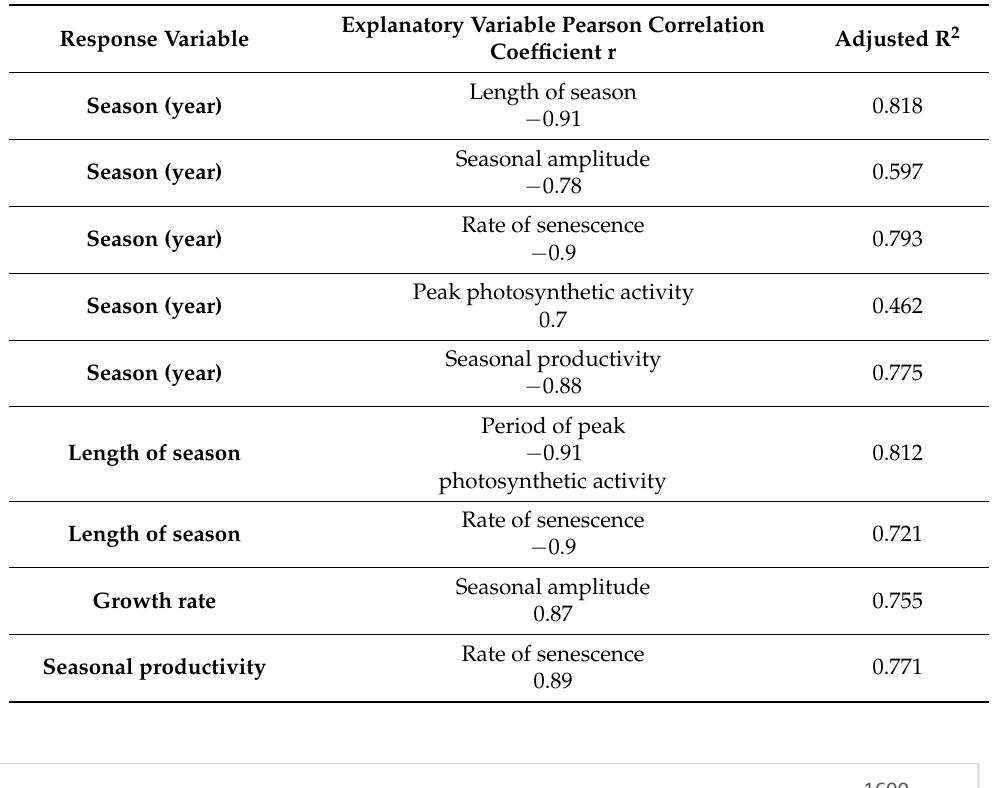
Table 4. Response and explanatory variables used in the linear regression models with Pearson correlation coefficient r values and adjusted R 2 at significantly high values ( p < 0.001).